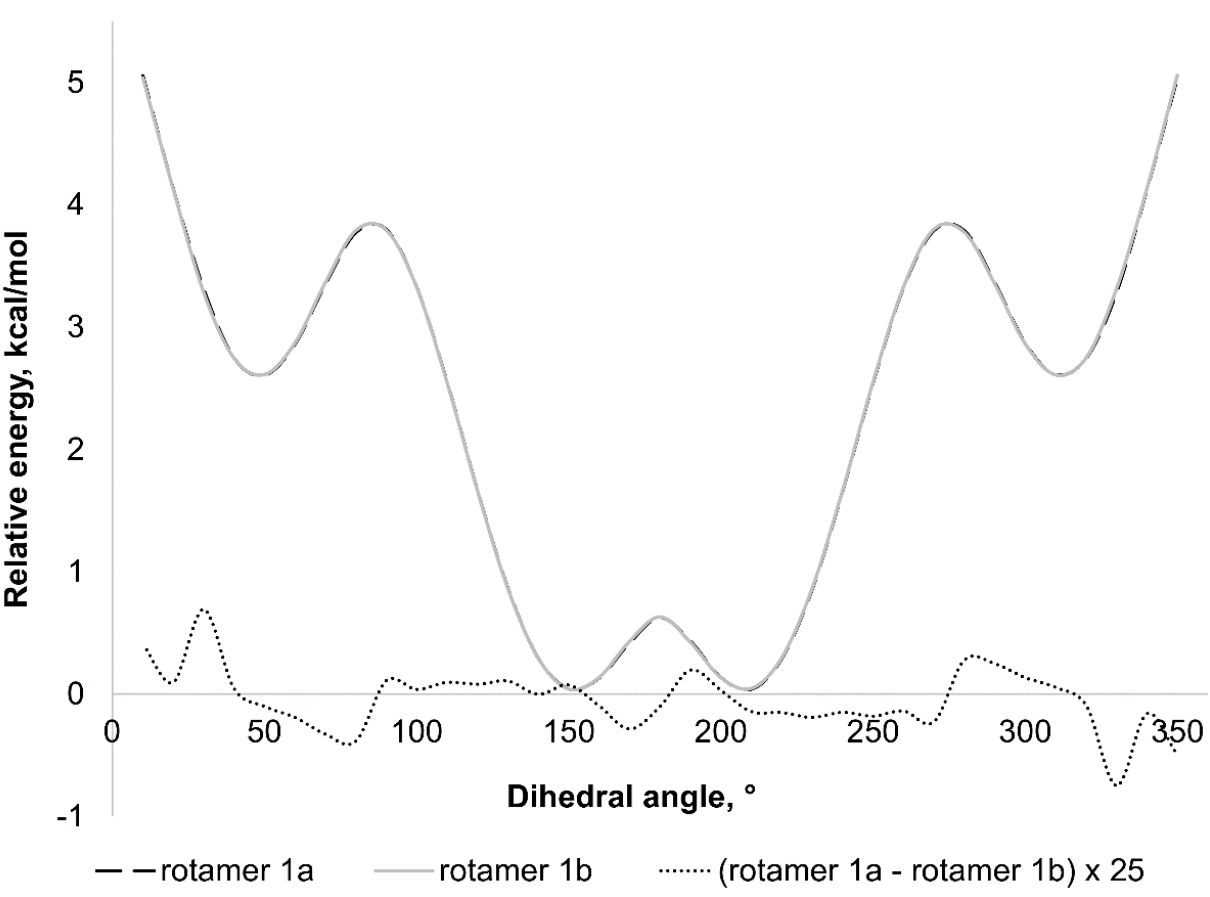
Figure 6. Relative energy profiles for the rotation around the C(5)–C(6)/C(5A)–C(6A) bond in rotamers ( 1a ) and ( 1b ). The difference between relative energies of the two rotamers multiplied by 25 is shown by the dotted line. Table 2. Important contacts (Å) in the extrema of the energy rotational curves of rotamers ( 1a ) and ( 1b ). Contact Extremum